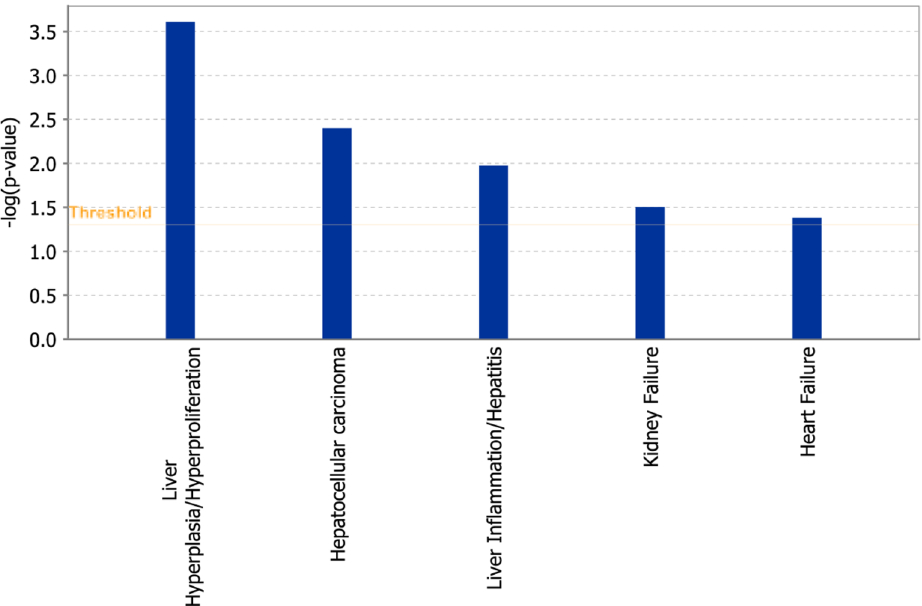
Figure 8. Significant canonical pathways identified by Ingenuity Pathway Analysis (IPA). Genes related to TANC1 gene (Supplementary Fig. S1) were significantly enriched in the above 5 pathways. The image was generated through the use of IPA (QIAGEN Inc. software version 65367011, https:// www. qiage nbioi nform atics. com/ produ cts/ ingen uity- pathw ay- analy sis) 23